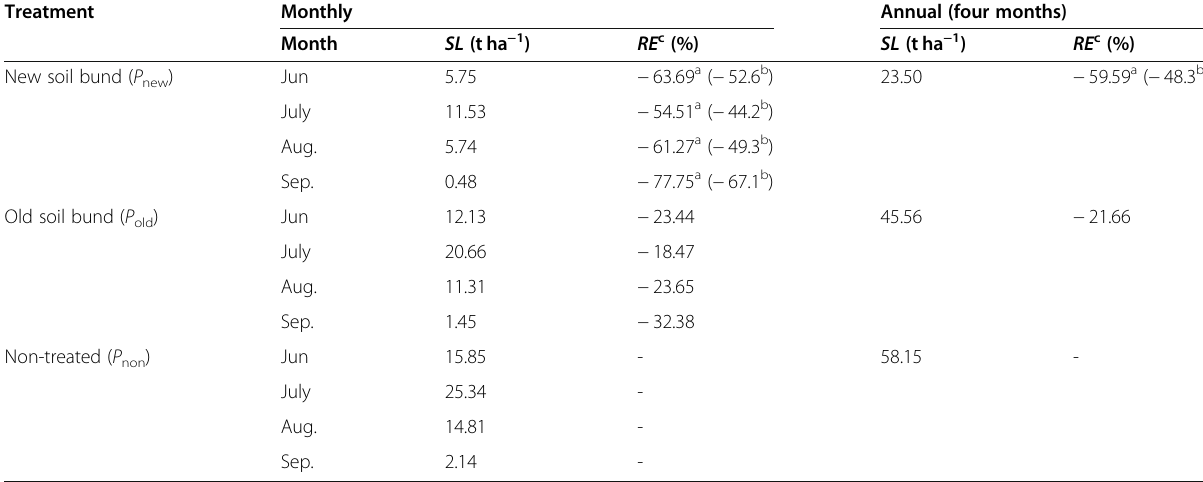
Table 4 Monthly and annual soil loss ( SL ) of treatments and the relative effect ( RE ) of graded soil bund treated as compared to the non-treated plots